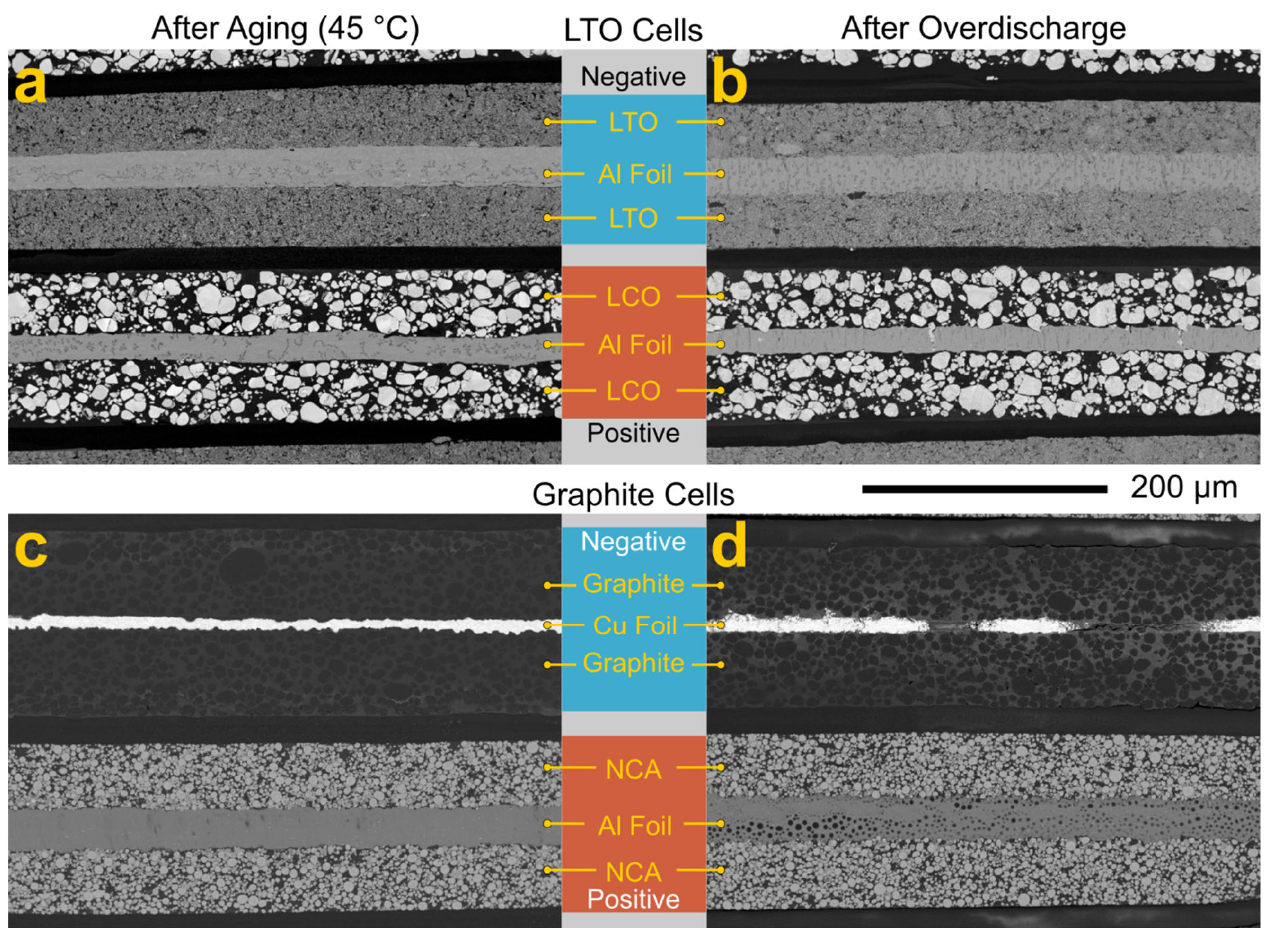
Figure 8. Backscatter electron micrographs of electrodes from the cross-sectioned LTO ( top row ) and graphite ( bottom row ) cells. ( a ) An LTO cell after aging at 45 ◦ C; ( b ) an LTO cell after overdischarge testing; ( c ) a graphite cell after aging at 45 ◦ C; ( d ) a graphite cell after overdischarge testing. The images here are representative and do not correspond to the specific locations shown in Figure 7. The images were collected with a 3 keV electron beam. All images are scaled equally.